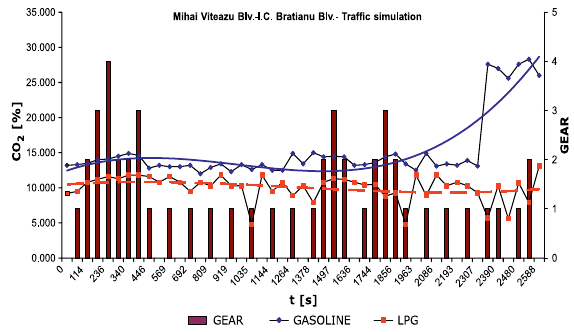
Fig. 13. Compared CO 2 emission versus time (air conditioning unit is turned off) for petrol/LPG fuel